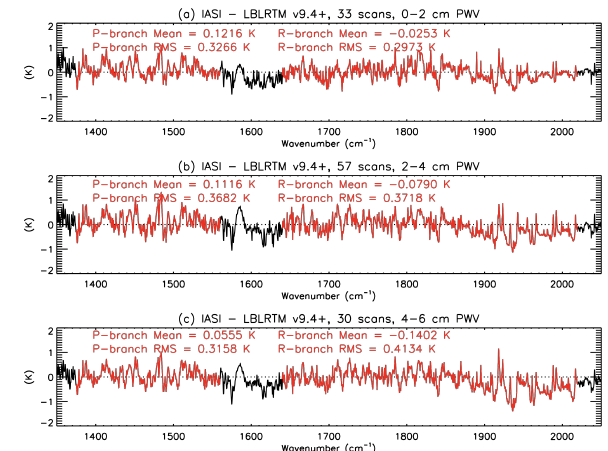
Fig. 16. Mean final (a posteriori) brightness temperature residuals in the ν 2 band of H 2 O using LBLRTM v9.4 + as in Fig. 12c, but only for profiles with (a) 0 to 2cm, (b) 2 to 4cm, and (c) 4 to 6cm of precipitable water